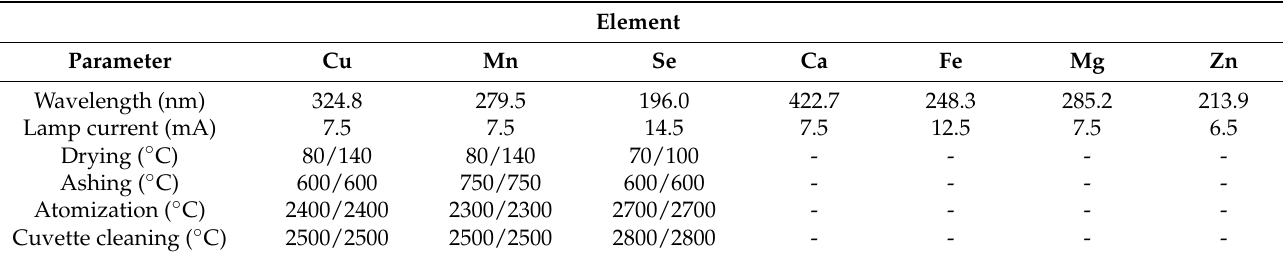
Table 1. The analytical conditions of flameless AAS technique (Cu, Mn and Se) and flame AAS technique (Ca, Fe, Mg and Zn) in determining the content of elements in rice samples.